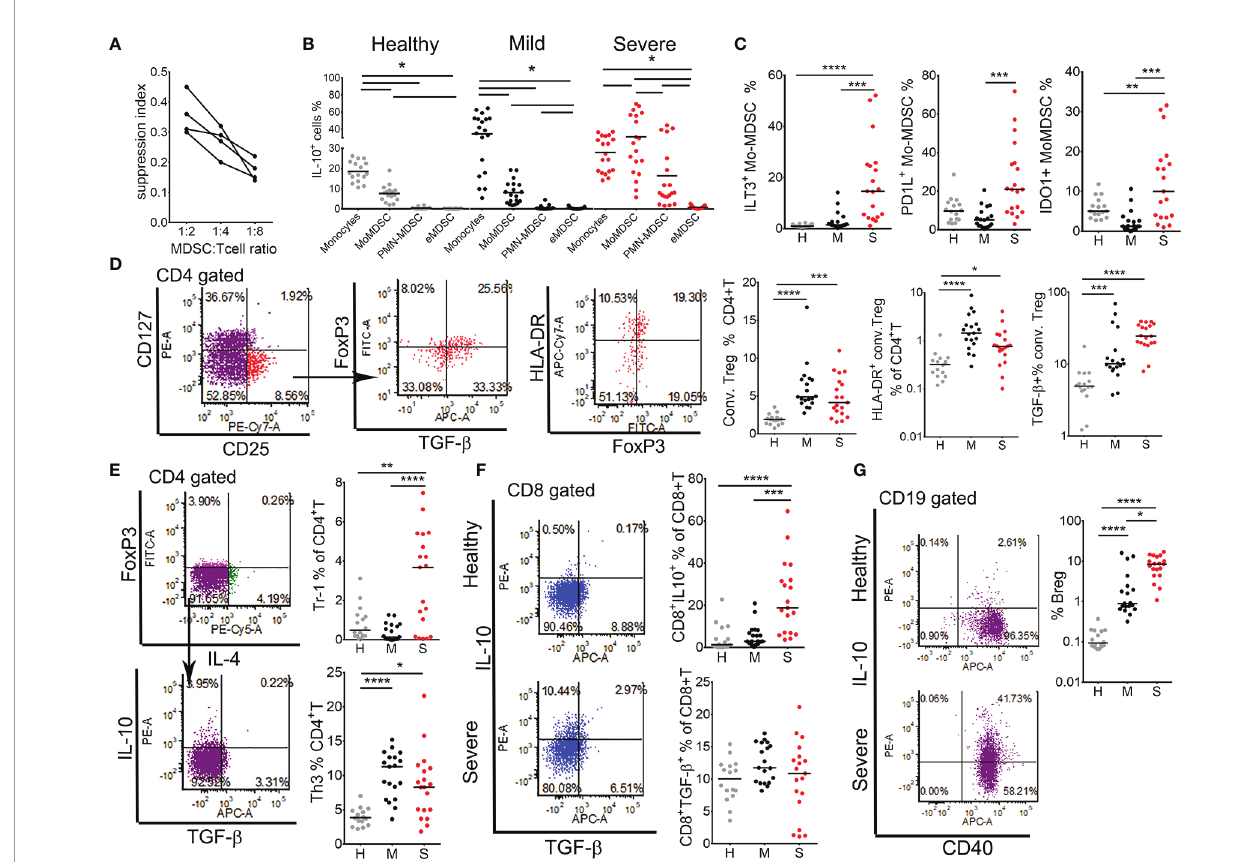
FIGURE 6 | Analysis of regulatory mechanisms in myeloid derived suppressor cells (MDSC) and regulatory lymphocytes. (A) Suppression capacity of monocytic cells (0.5 × 10 5 , 0.25 × 10 5 , 0.12 × 10 5 cells/well) isolated from four severe patients by MACS was tested in co-culture with allogeneic MACS puri fi ed T cells (1 × 10 5 ) from a healthy donor treated with CD3/CD28 beads. The suppression index was calculated as 1 - % of T cells proliferation in co-culture with monocytic cells, divided by % of T cells proliferation in control cultures without monocytic cells. (B) The percentages of IL-10 + monocytes, Mo-MDSC, PMN-MDSC and eMDSC (gated as in A and B in Figure 5 ) in healthy donors, mild, and severe COVID-19 patients are shown. Horizontal lines between the histograms indicate statistical signi fi cance at p<0.05. (C) The percentages of ILT-3 + , PD-L1 + , and IDO-1 + Mo-MDSC, gated as in Figure 5B , are expressed as the proportion of cells in monocytes region. (D) Conventional (conv.) Tregs were gated from CD4 + T cells as CD127 - CD25 + FoxP3 + cells. Total percentages of conv. Tregs and HLA-DR + (activated) Tregs are shown as the proportion of CD4 + T cells. The percentage of TGF- b + cells is shown as the proportion of total conv. Tregs. (E) Type 1 regulatory (Tr-1) and Th3 cells were gated as CD4 + FoxP3 - IL4 - IL-10 + and CD4 + FoxP3 - IL4 - TGF- b + cells, respectively. (F) Expression of IL-10 and TGF- b were analyzed in CD8 + T cells and representative dot-plots from one healthy and one severe patient are shown. (G) B regulatory (Breg) cells were gated as CD19 + CD40 + IL-10 + cells and representative dot-plots from a healthy and a severe patient are shown. (C – G) Summarized data from 16 healthy donors (H, gray dots), 19 mild (M, black dots), and 19 severe (S, red dots) COVID-19 patients are shown as the percentage of gated lymphocytes or as indicated. *p < 0.05, **p < 0.01, ***p < 0.005, ****p < 0.001 as indicated (Kruskal-Wallis test with Dunn ’ s